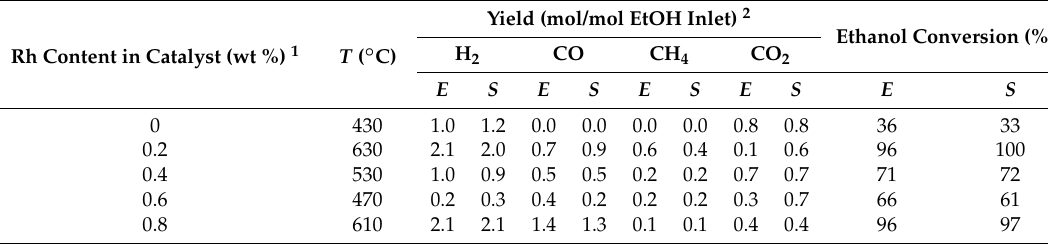
Yield (mol/mol EtOH Inlet) 2 Ethanol Conversion (%) H 2 CO CH